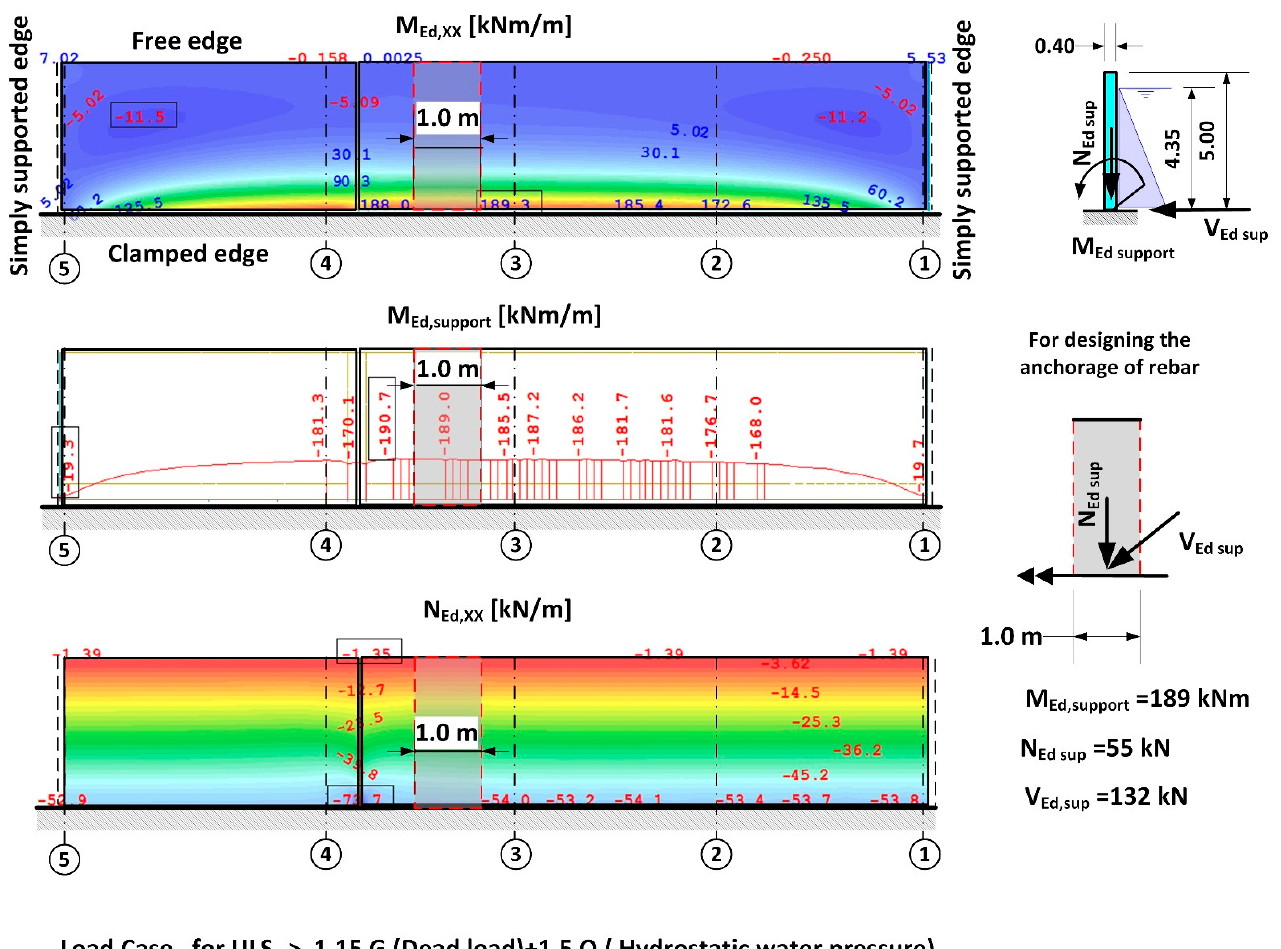
Figure 13. Static scheme of the wall for determining the reactions of the supports for verifying the load bearing capacity of the rebars in the foundation